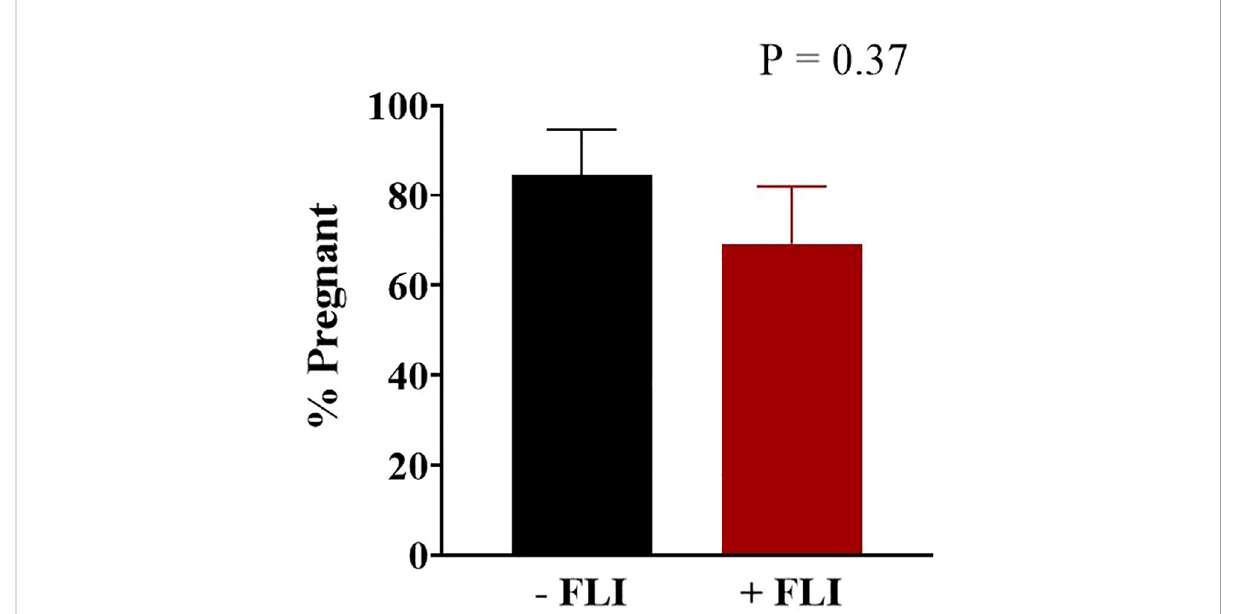
FIGURE 2 Survival at day 15 of bovine embryos supplemented with and without FLI during culture. At embryo transfer, recipient females (n = 26) received embryos treated with or without FLI. On day 15, females were identi fi ed as pregnant or open (non-pregnant) based on the presence of at least one conceptus ( P = 0.37). Values are presented as least squares means ±